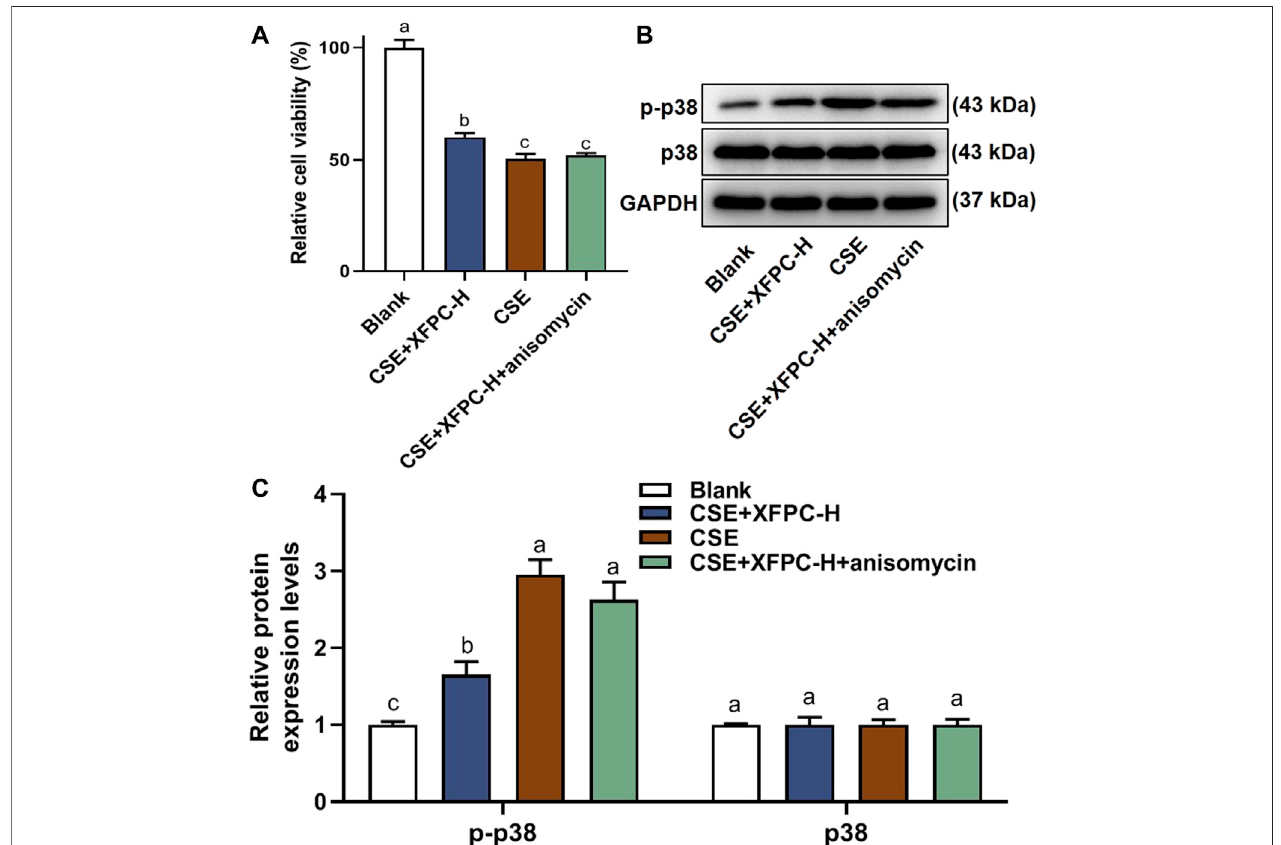
FIGURE6| XFPCcouldpromotescellgrowthbyinhibitingp38phosphorylation. (A) EffectofXFPC-Handp38activatoranisomycinoncellviabilityinCSE-exposed HBE. Data are presented as mean ± SD from three independent experiments. (B) The protein expression of p38 and p-38 in HBE cells after XFPC-H or anisomydin treated. (C) Quanti fi cation ofthelevels ofp38 and p-p38 inprotein level ofpanel (B) .Lowercaseletters indicate statistically signi fi cantdifferences ( p < 0.05) accordingto ANOVA followed by Tukey ’ s HSD test. XFPC, Xuanfei Pingchuan Capsules; CSE, cigarette smoke extract; HBE cells, human bronchial epithelial